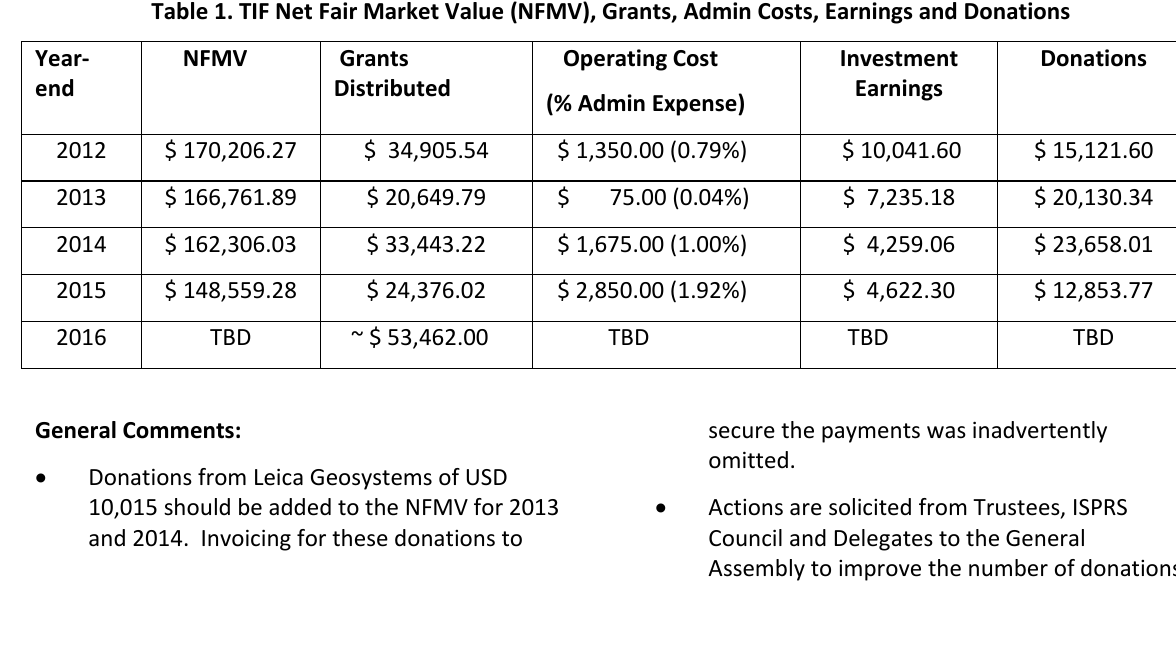
Table 1. TIF Net Fair Market Value (NFMV), Grants, Admin Costs, Earnings and Donations